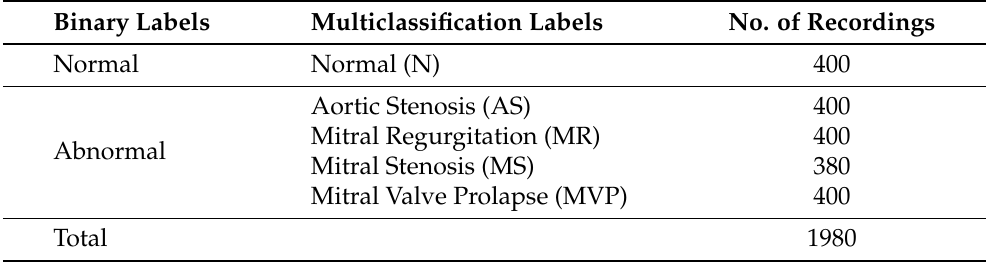
Table 1. Details of the